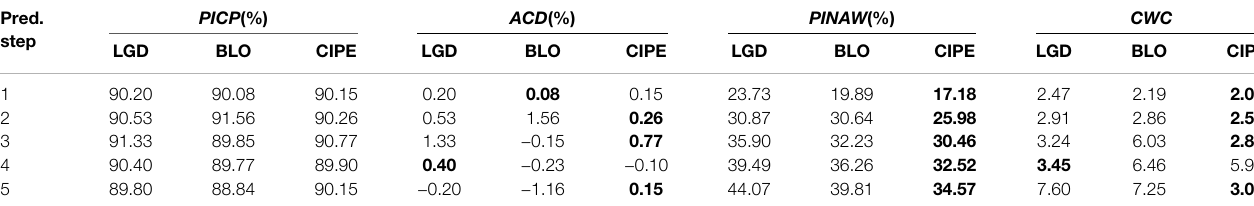
TABLE 4 | Multi-step ahead prediction results of LGD, BLO, and CIPE under PINC = 90%. Pred.